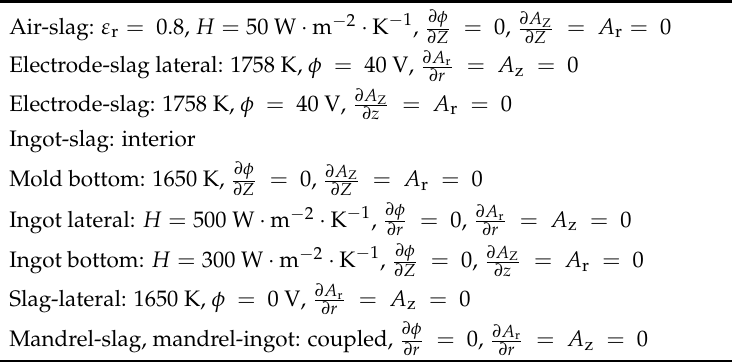
Table 1. Thermal and electrical boundary